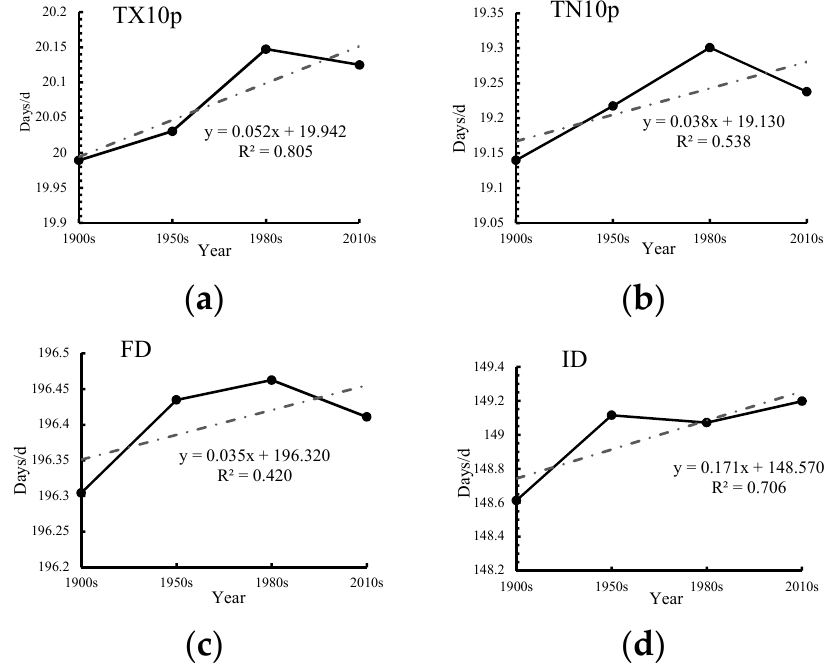
Figure 5. Trends in absolute indexes of annual extreme temperature events in Heilongjiang Province between the 1900s and 2010s. ( a ) Cold days; ( b ) Cold nights; ( c ) Frost days; ( d ) Ice days.